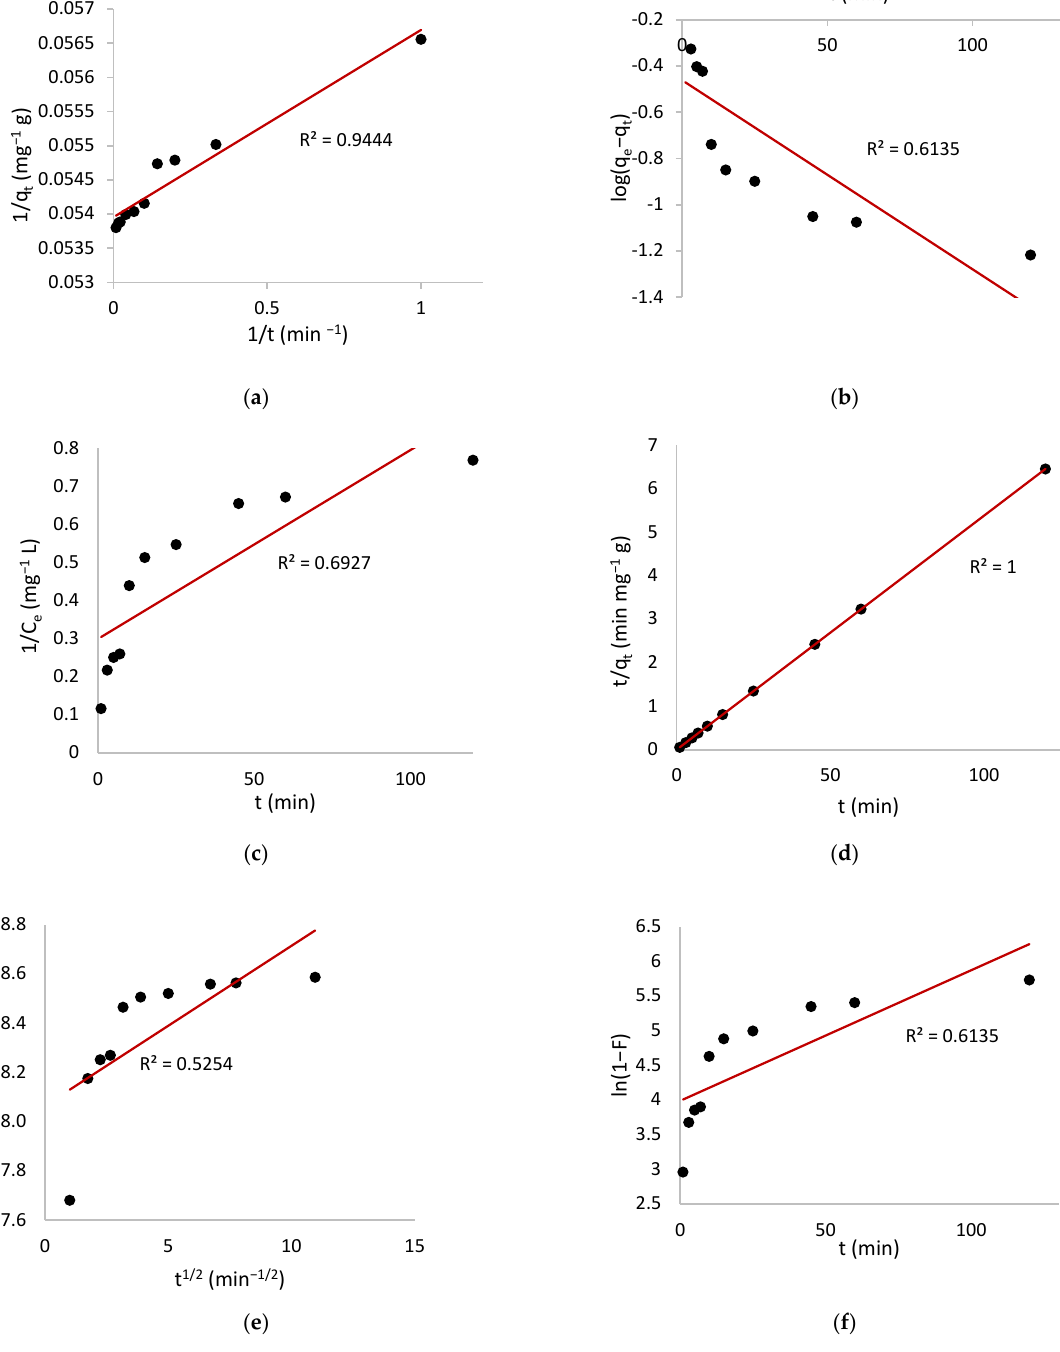
Figure 7. Kinetic model plots for MV adsorption onto HNC ( a ) first order, ( b ) pseudo-first order, ( c ) second order, ( d ) pseudo-second order, ( e ) intraparticle diffusion and ( f ) liquid film diffusion. On the basis of the high values of the regression coefficient, (R = 1) and very close values of q e,calc with q e,exp , the pseudo-second-order rate model fitted the experimental data better than any other model studied, providing evidence that the adsorption of MV on